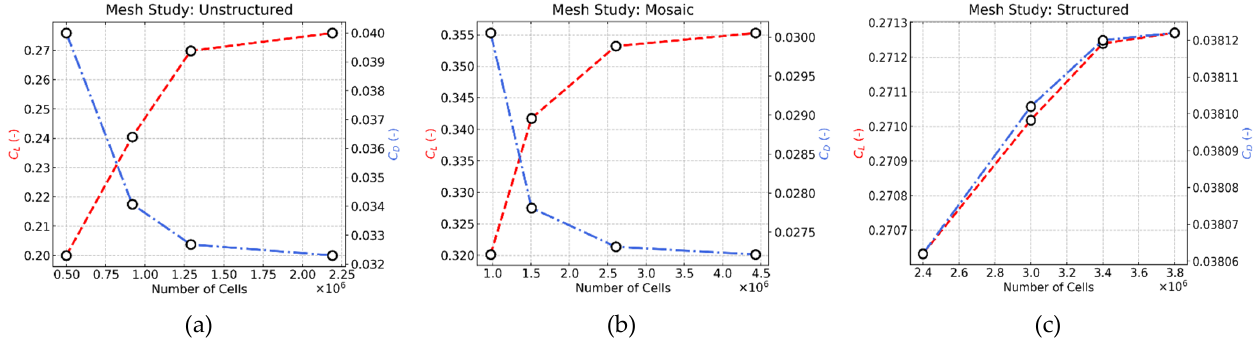
Figure 3. Mesh independence study for ( a ) Unstructured grid ( b ) Mosaic Poly-hexcore grid ( c ) Struc- tured grid.